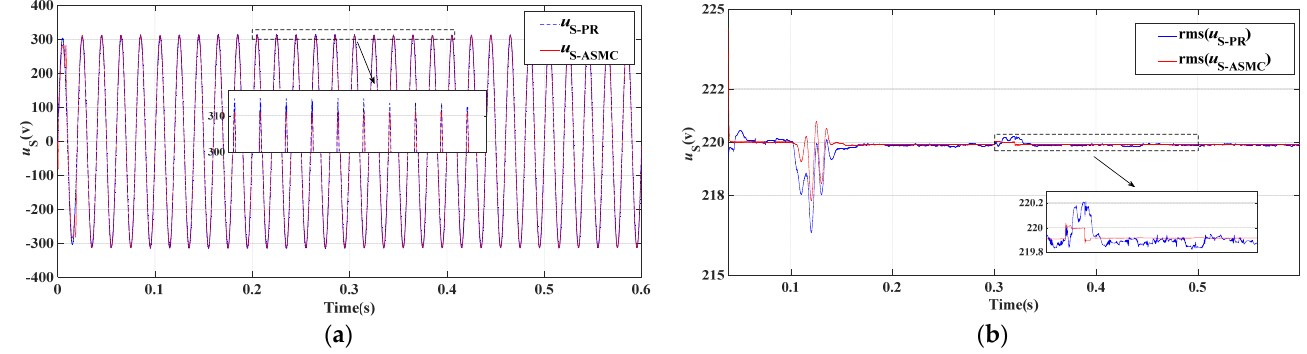
Figure 9. Voltage-stabilizing capacity of ASMC and PR control when L changes: ( a ) waveform comparison, ( b ) RMS comparison.